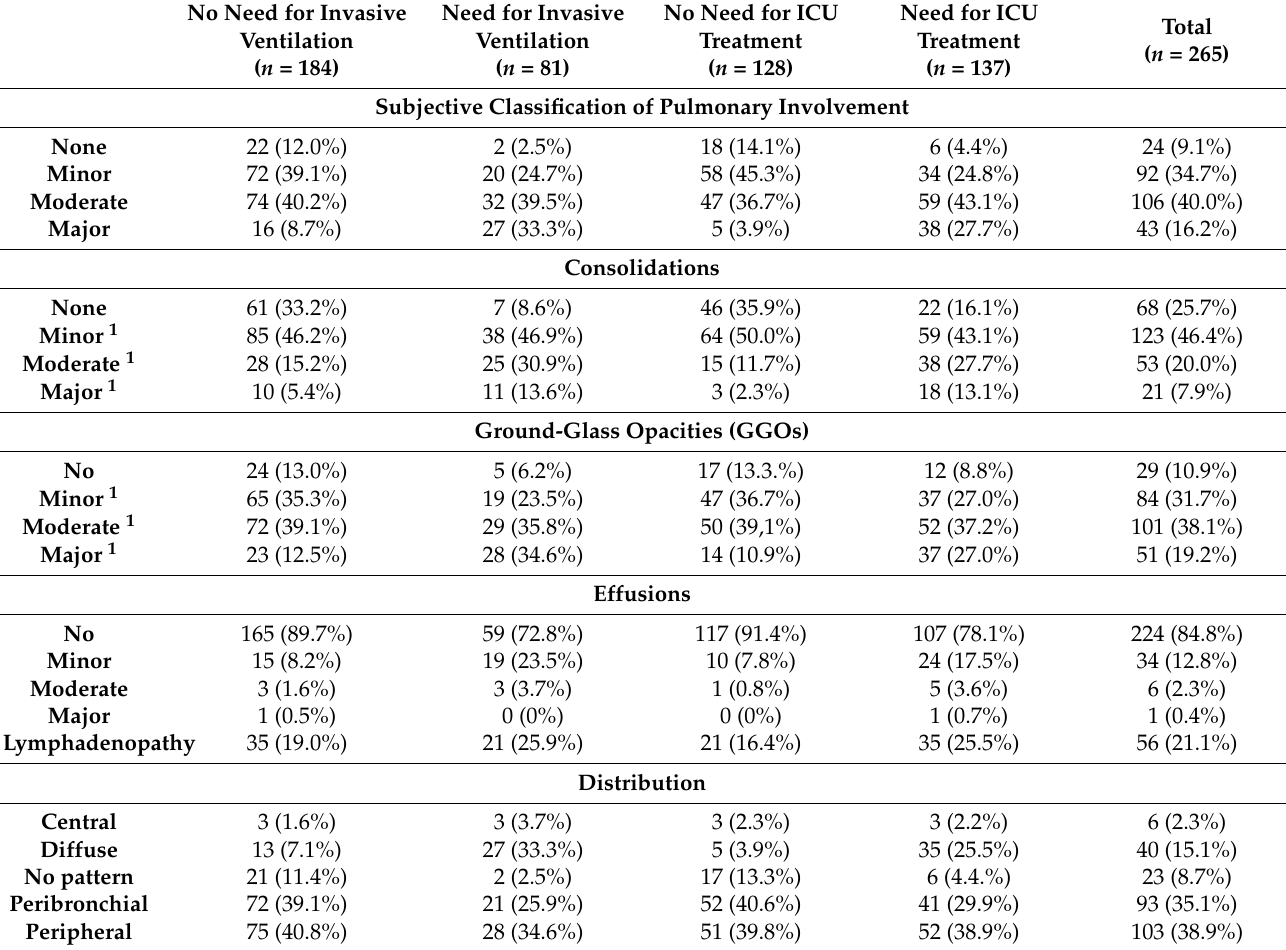
Table 2. Synopsis of subjective CT scan readings. The predominant findings in the CT scans were ground-glass opacities (89.1% of all patients) and consolidations (74.3% of all patients); pleural effusions and lymphadenopathy were rarely found. Patients who later needed invasive ventilation or ICU admission were more severely